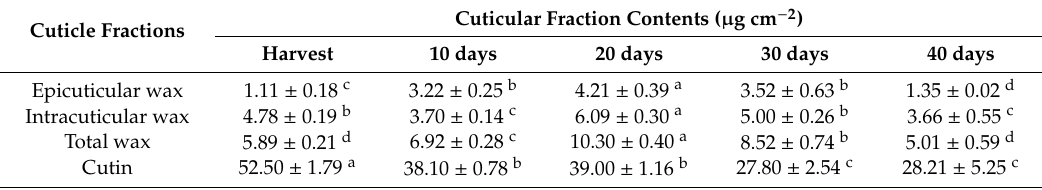
Table 1. Changes in cuticular fraction contents of the ‘Satsuma’ mandarin fruits during